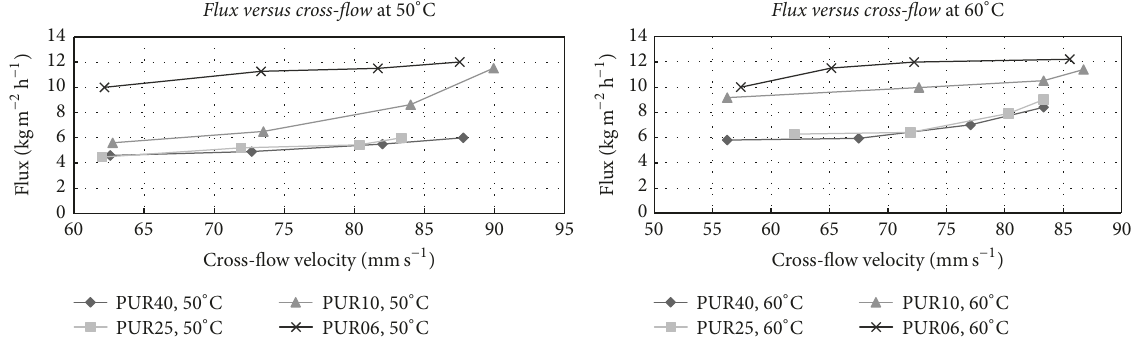
Figure 3: The effect of tangential velocity on transmembrane flux at 50 ∘ C and 60 ∘ C.